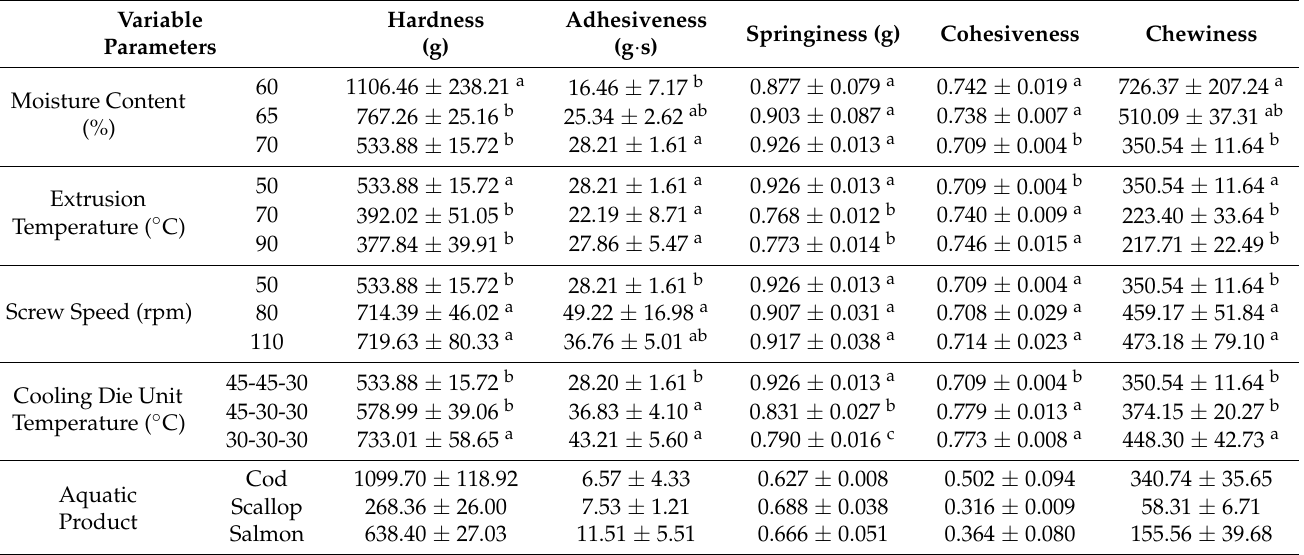
Table 2. Texture profile analysis (TPA) of extrudates under different processing conditions and three aquatic products 1